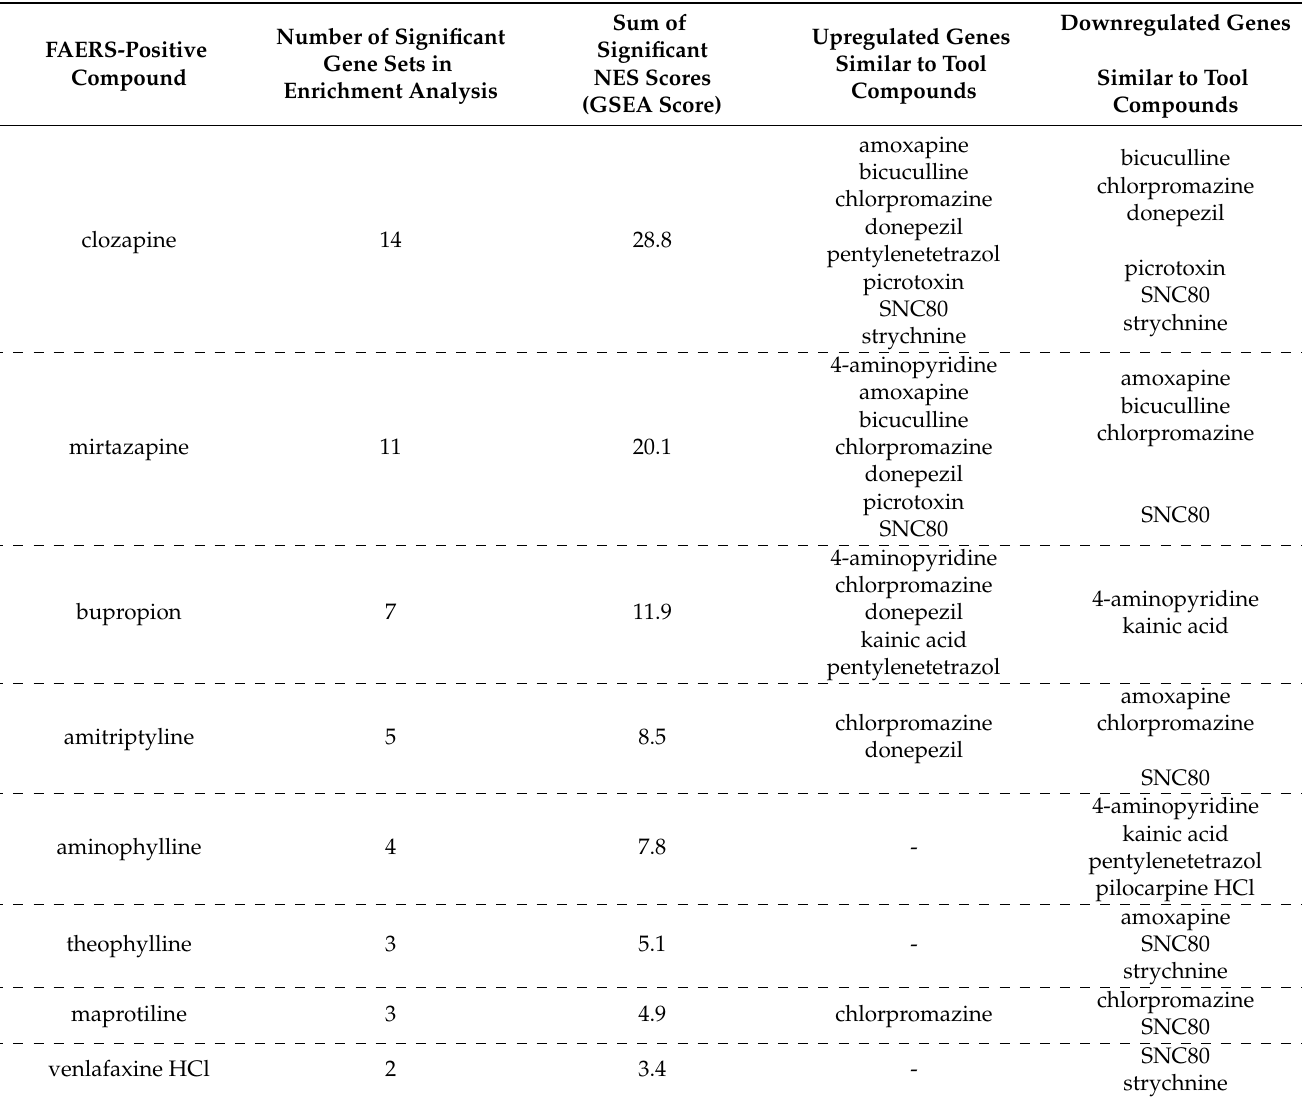
Table 6. Sum of the normalized enrichment score (NES) base values for the FEARS-positive com- pounds (GSEA score) and the number of enriched gene sets in the enrichment analysis with FEARS- positive drugs and tool compounds. For each tool compound, a gene set was generated from the upregulated and downregulated genes, which were then compared to a ranked list of each FEARS-positive